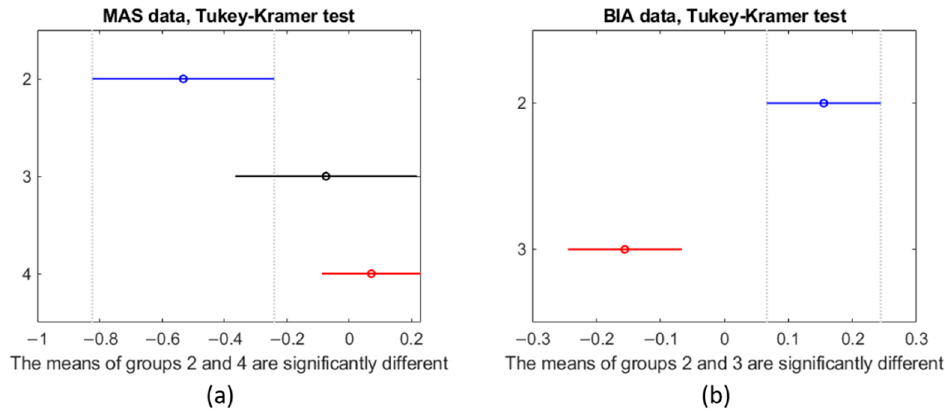
Figure 13. Results of the Tukey–Kramer test of the ( a ) MAS data and on the ( b ) BIA data. The y-axis indicates the group number.